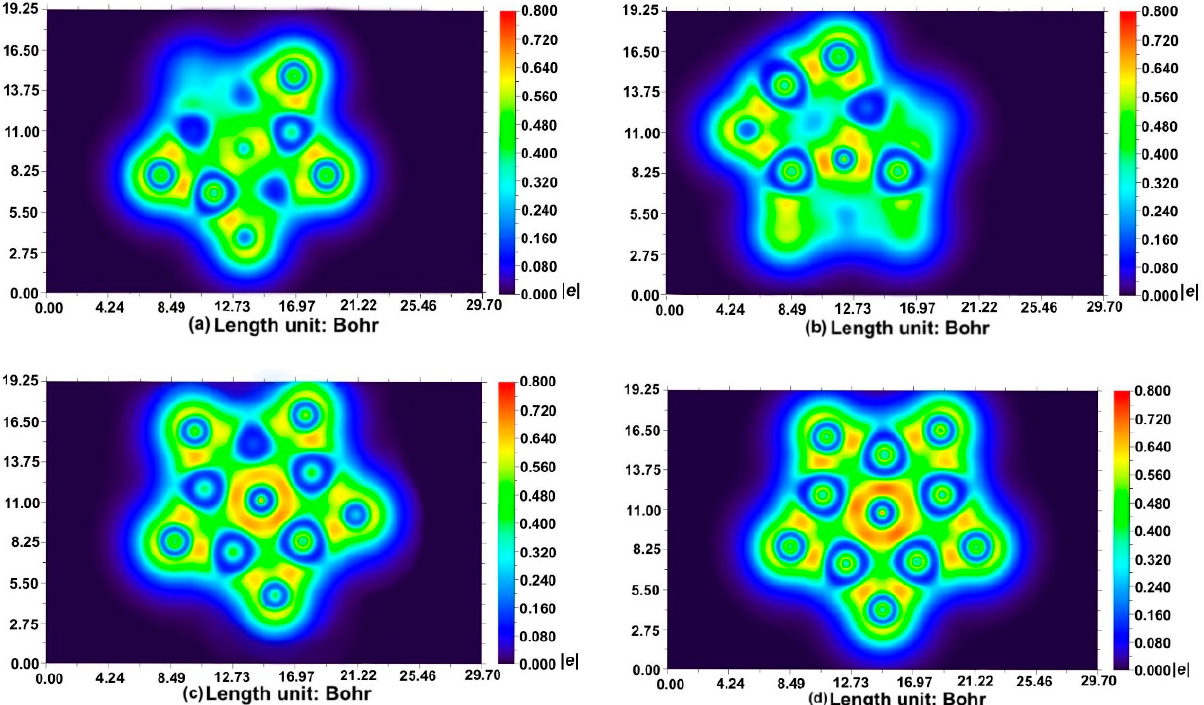
Figure 3. Localized orbital locator (LOL) analysis of ( a ) CAl 5 S 5+ , ( b ) CAl 5 S 52+ , ( c ) BAl 5 S 5 , ( d ) BAl 5 S 5+ .